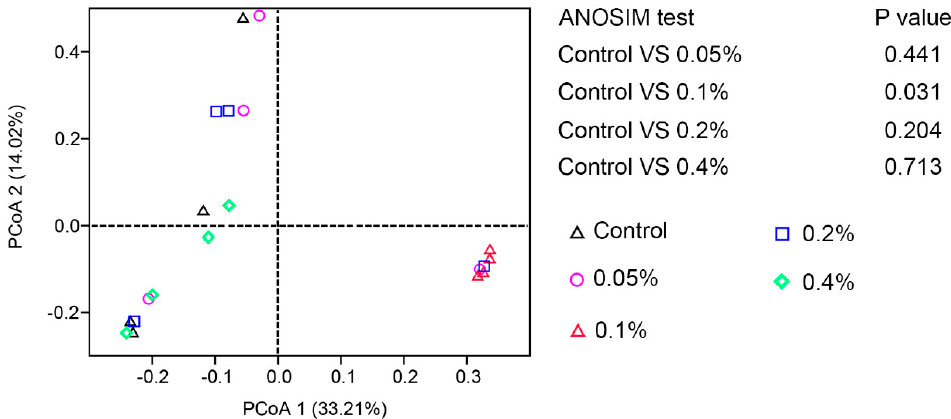
Figure 5. Effects of different doses of β -glucan on the gut microbiota composition of Juvenile L. vannamei at the phylum and genus levels. ( A ) Microbiota composition at the phylum level with the relative abundance of the top four. ( B ) Relative abundance of gut microbiota at the phylum level. ( C ) Differences in the relative abundance of phylum taxa among groups. ( D ) Microbiota composition at the genus level with the relative abundance of the top thirteen. ( E ) Relative abundance of gut microbiota at the genus level. ( F ) Differences in the relative abundance of genus taxa among groups. Different letters indicate significant differences ( p < 0.05) among groups. All data are expressed as the mean ± SE ( n = 4).